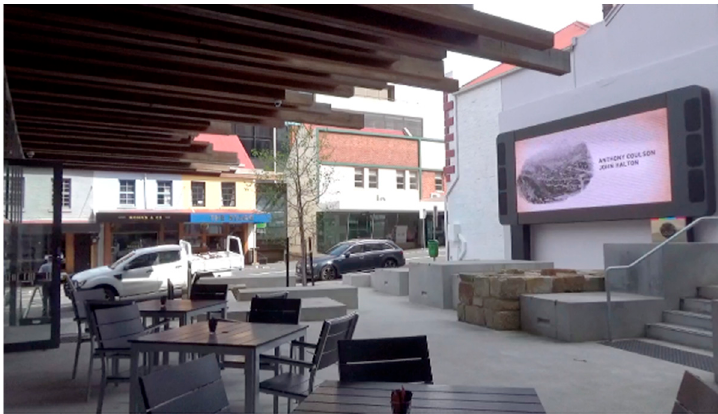
Figure 5. Caf é exterior, including “The Loop” video Figure 5. Café exterior, including “The Loop” video installation.